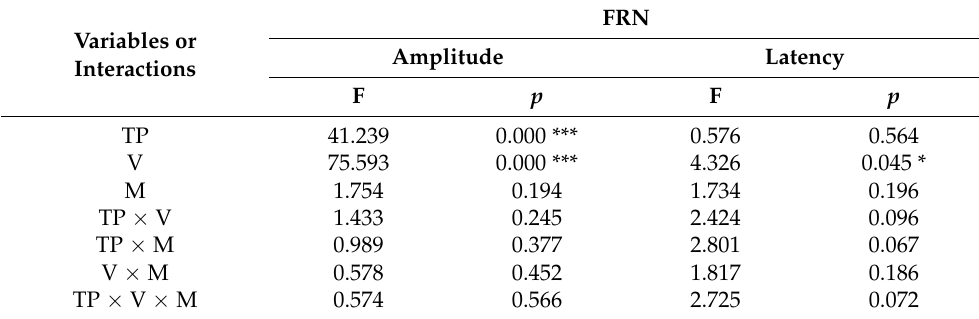
Table 2. Repeated measures ANOVA results. Variables